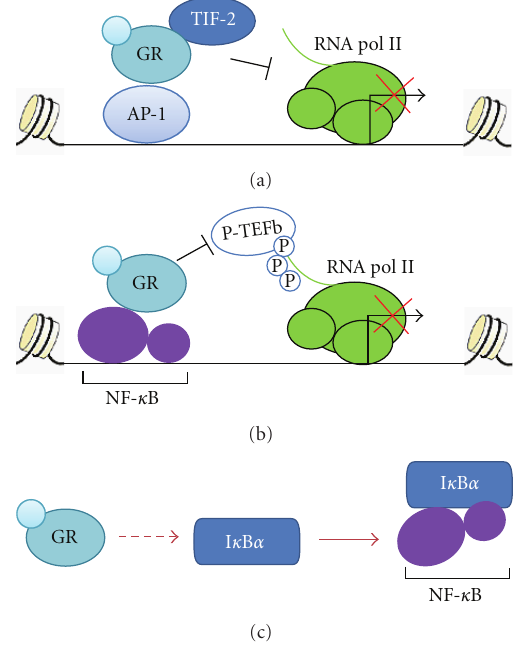
Figure 2: Molecular mechanisms of GR transrepression of AP-1 and NF- κ B. (a) Ligand-activated GR is tethered to AP-1 and recruits transcriptional mediators/intermediary factor 2 (TIF-2) to inhibit transcription of AP-1 target genes. (b) Ligand-activated GR bound to NF- κ B interferes with recruitment of NF- κ B Ser2 CTD kinase, positive transcription elongation factor b (P-TEFb), which is re- quired for the transcription of proinflammatory genes. (c) Ligand- activated GR induces synthesis of I κ B α , thereby blocking NF- κ B nuclear